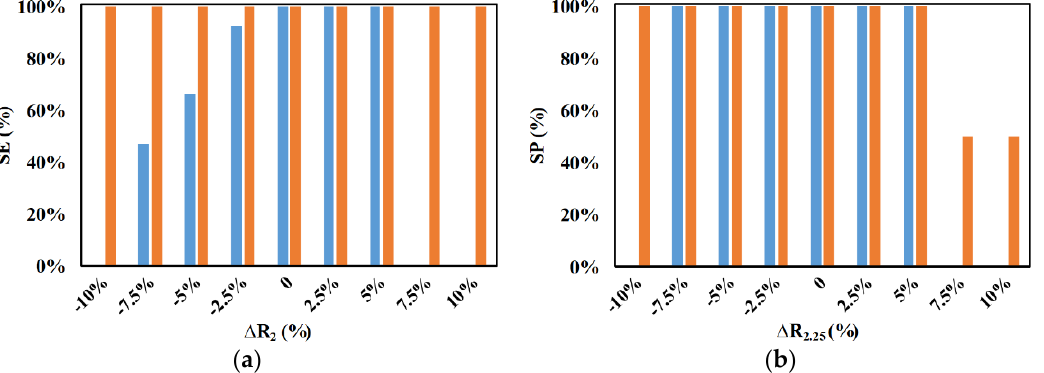
Figure 14. E ff ect of variations in radius of small microparticles on SE and SP for ( a ) (cid:4) 2 µ m (at 0%) and Figure 14. Effect of variations in radius of small microparticles on SE and SP for ( a ) ■ 2 μm (at 0%) ( b ) (cid:4) 2.25 µ m ( d f = 60 µ m, l f = 120 µ m, d s = 60 µ m, l s = 120 µ m, w f = 6 µ m, w s = 6 µ m, n f = 200, n s = 200, and ( b ) ■ 2.25 μm ( d f = 60 μm, l f = 120 μm, d s = 60 μm, l s = 120 μm, w f = 6 μm, w s = 6 μm, n f = 200, n s = V 1 = 3 V pp , V 2 = 15 V pp , V 3 = 15 V pp V 4 = 3 V pp , H ch = 50 µ m, W ch = 50 µ m, 0 < W o ,2.25 < 30 µ m, 200, V 1 = 3 V pp , V 2 = 15 V pp , V 3 = 15 V pp V 4 = 3 V pp , H ch = 50 μm, W ch = 50 μm, 0 < W o,2.25 < 30 μm, 30 μm < 30 µ m < W o ,2 < 50 µ m, N 1 = N 2 = 10 MHz, N 3 = N 4 = N cr ,2 = 473 W o,2 < 50 μm, N 1 = N 2 = 10 MHz, N 3 = N 4 = N cr,2 = 473 kHz).